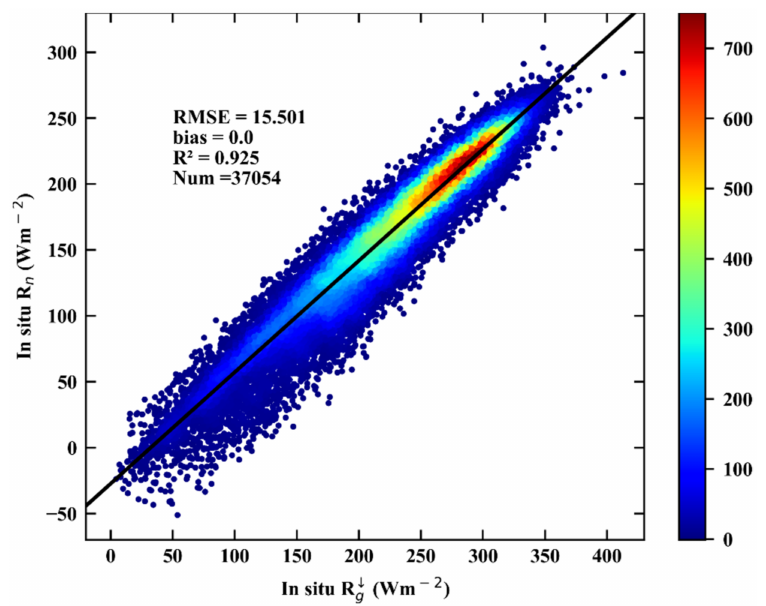
Figure 3. Scatter plot showing relationship between the in situ daily ocean surface R n and R ↓ g